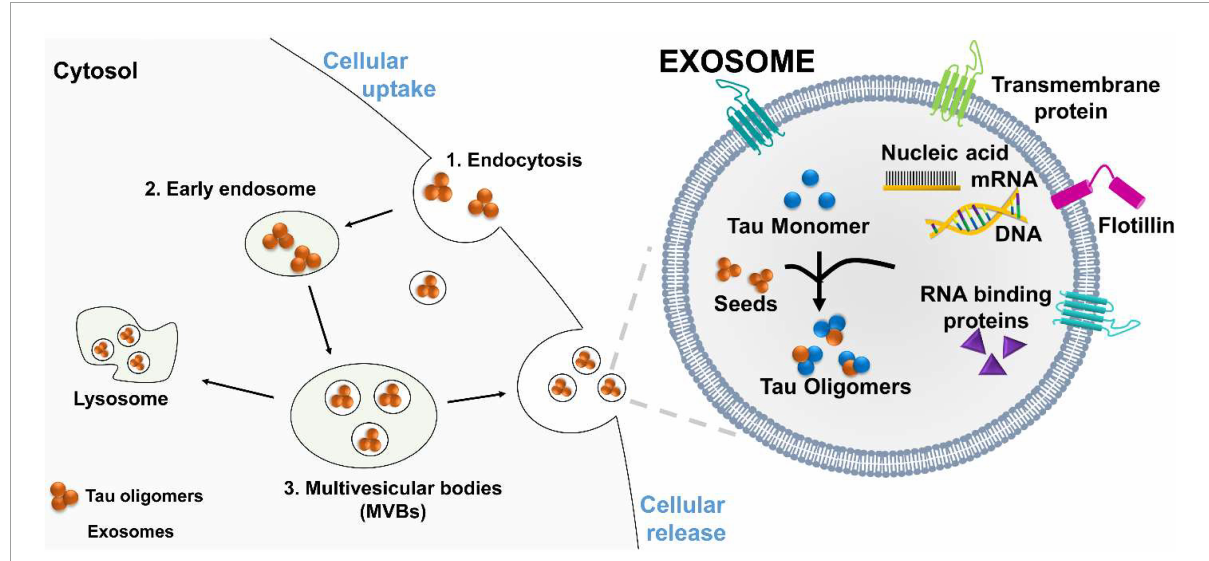
FIGURE2 Proposed mechanism of tau oligomers spreading via exosomes. Exosomes are vesicles that carry RNA binding protein (RBP), nucleic acids, monomeric, and oligomeric tau. Exosomes facilitated oligomers formation and deliver their toxic cargo, to a recipient cell. (1) Tau oligomers are endocytosed by the recipient cell, (2) and transported to an early endosome, which develops into a large (3) multivesicular bodies (MVBs). Tau oligomers are release by fusion of MVBs with the plasma